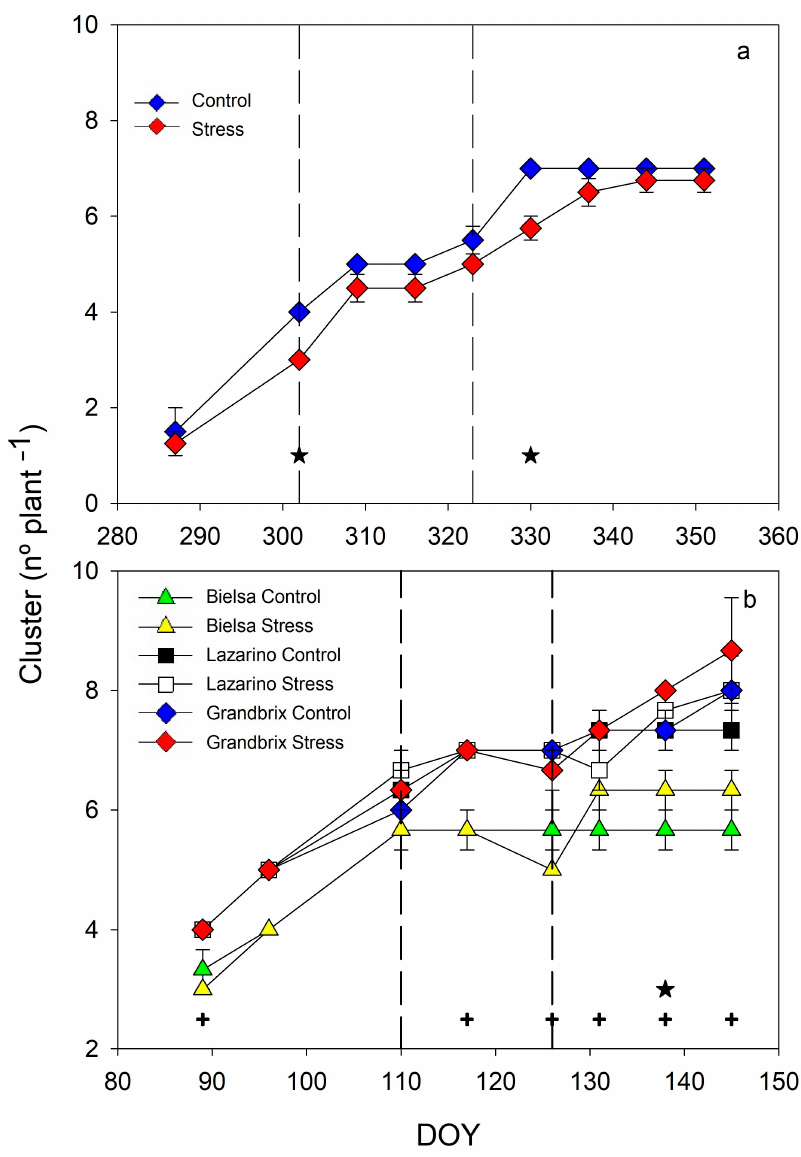
Figure 5. Pattern of cluster appearance along the autumn ( a ) and spring ( b ) experiments. Each symbol is the average of 4 (autumn cycle) or 3 (spring cycle) data. Vertical bars represent the standard error. Vertical lines show the period of water stress. Asterisks (irrigation treatments) and crosses (cultivars) indicate the date when significant differences were found ( p < 0.05).